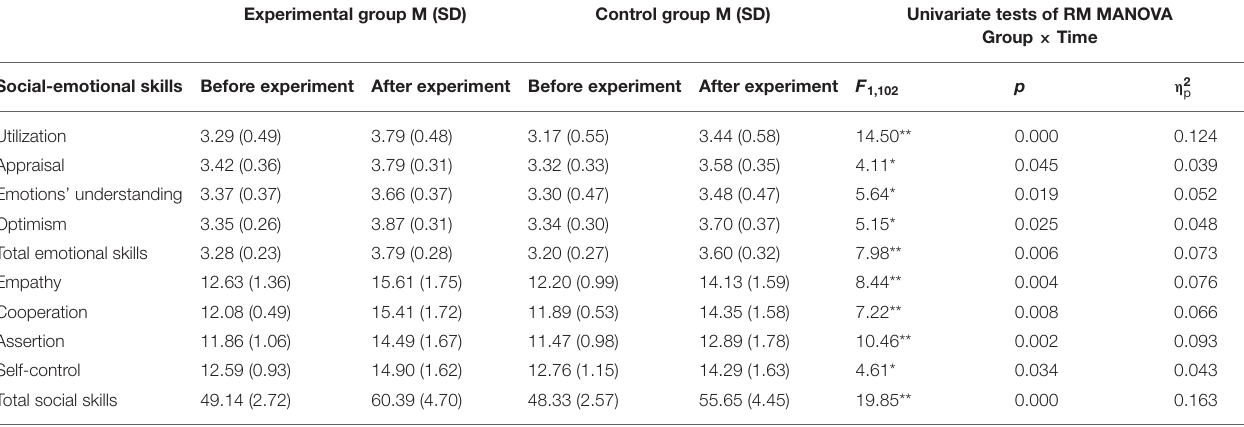
TABLE 4 | Mean scores of social-emotional skills of youth school students in physical education classes before and after the educational experiment. Experimental group M (SD) Control group M (SD) Univariate tests of RM MANOVA Group × Time Social-emotional skills Before experiment After experiment Before experiment After experiment F